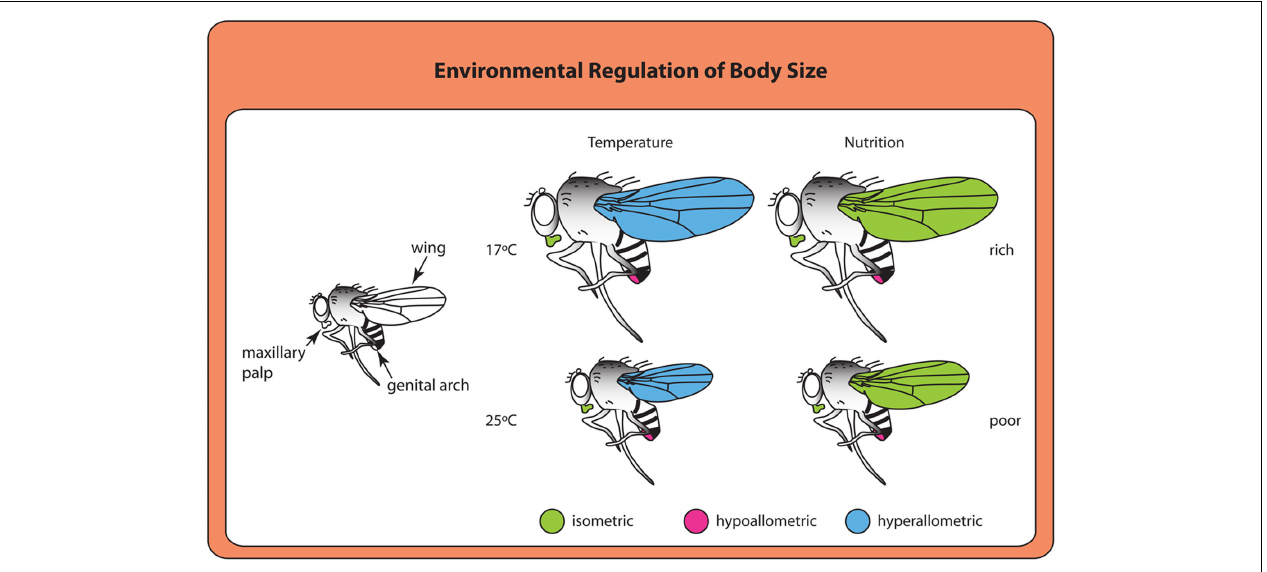
size. Hyperallometric scaling occurs when the size of a structure increases disproportionately with increasing body size. Structures that are hypoallometric do not increase or increase very little with increasing body